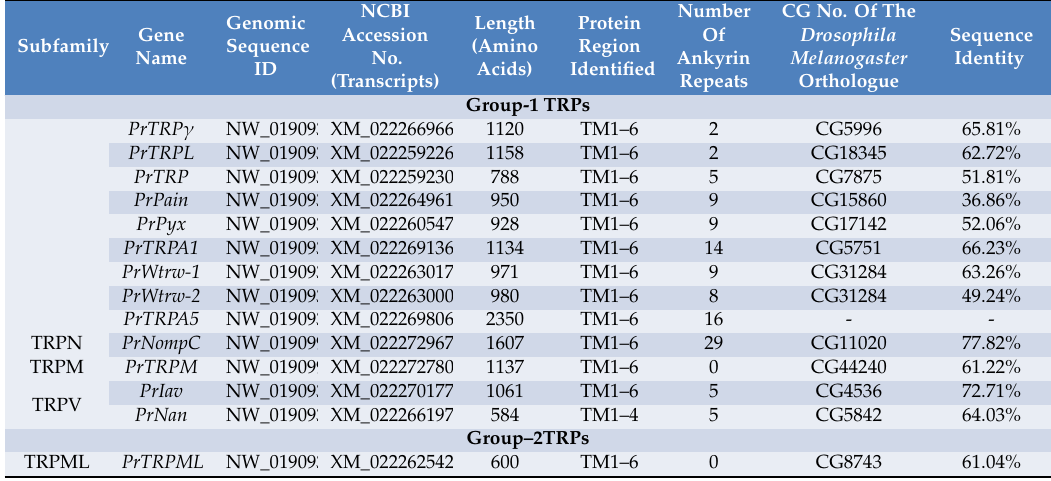
Table 1. Transient receptor potential (TRP) channels identified in P. rapae.